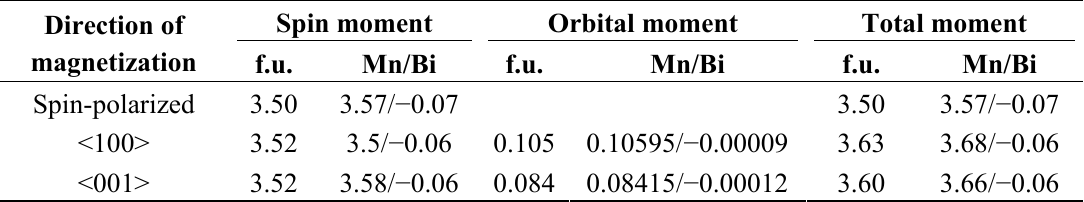
Table 1. The calculated spin and orbital magnetic moments per formula unit (f.u.) and Mn and Bi atoms for low temperature phase (LTP) MnBi in units of μ from both spin-polarized and spin-orbit coupling calculations are